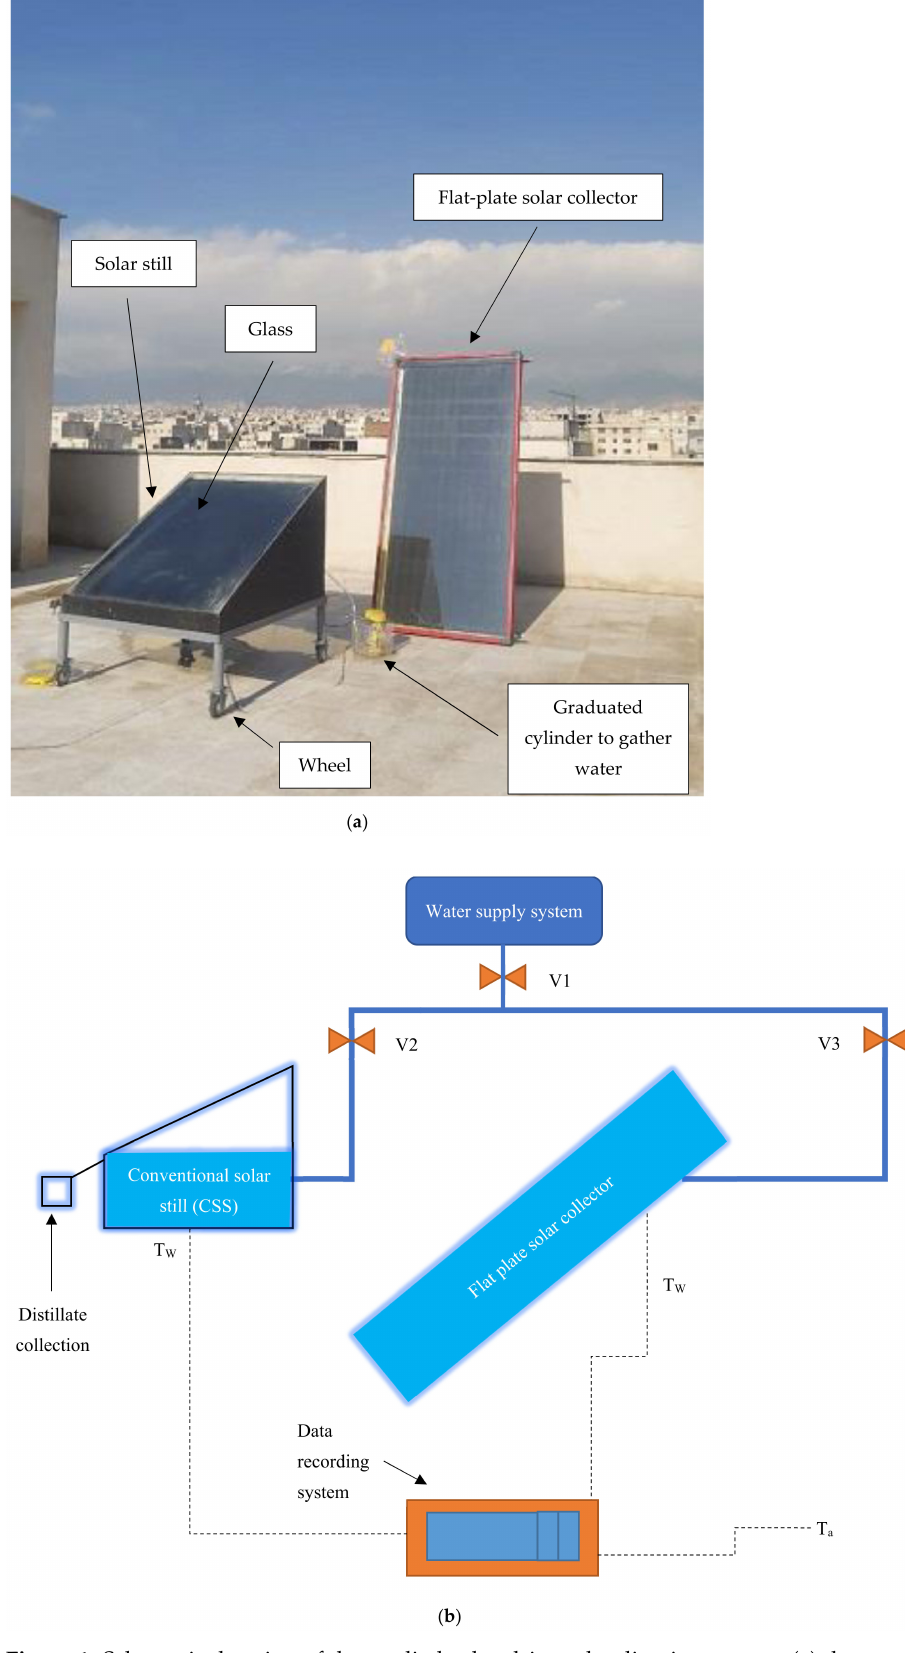
Figure 1. Schematic drawing of the studied solar-driven desalination system; ( a ) the components; ( b ) the piping and instrumentation